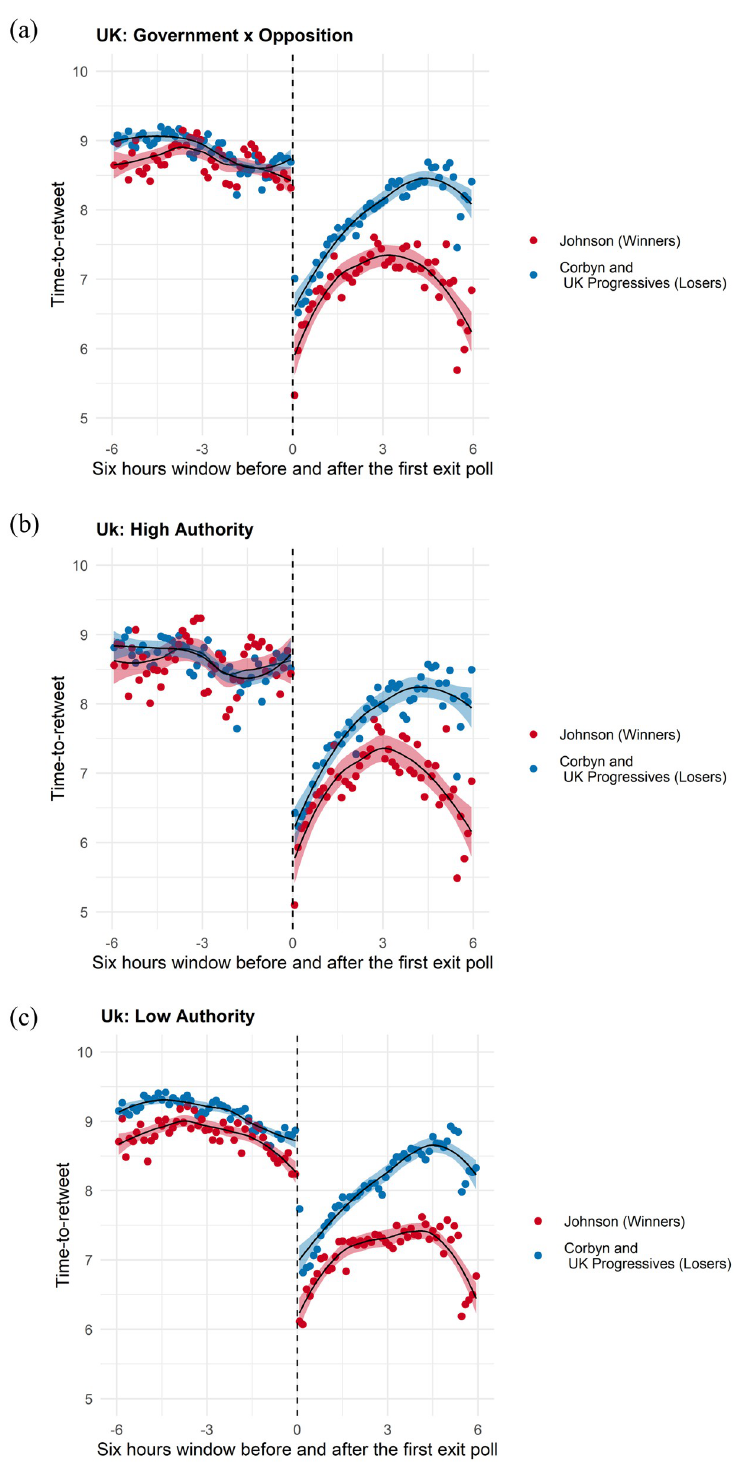
Fig 2. Time-to-retweet in the UK election. (a) Winners vs Losers, (b) High Authority Users, (c) Low Authority Users.